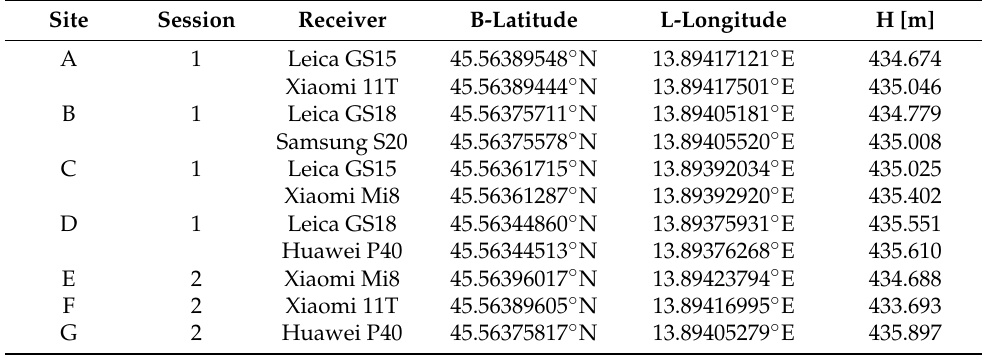
Table 3. Receivers’ setup from DOY 262 at the specific locations shown in Figure